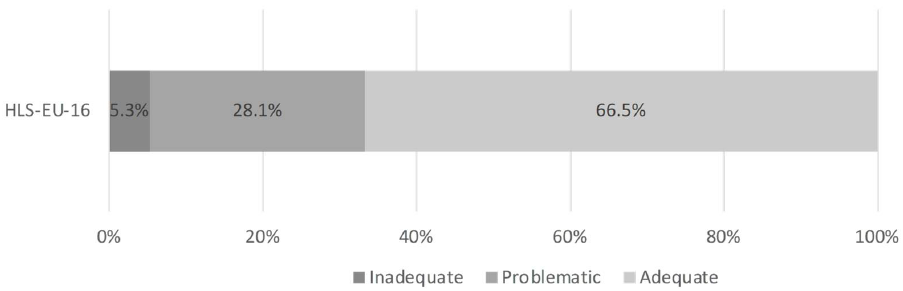
Figure 1. Results of the HLS-EU-16 (n = 1365). Multivariable regression analysis using the BHLS as the dependent variable did not show any intervention effects on the improvement of health literacy (ß = 0.086, 95% CI